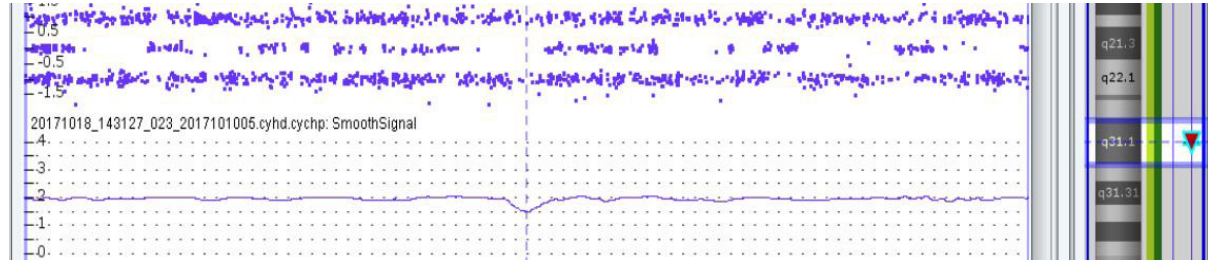
Figure 1: The patient’s aCGH analysis chart, in which the arrowhead refers to the part of the patient’s 58 kb deletion at